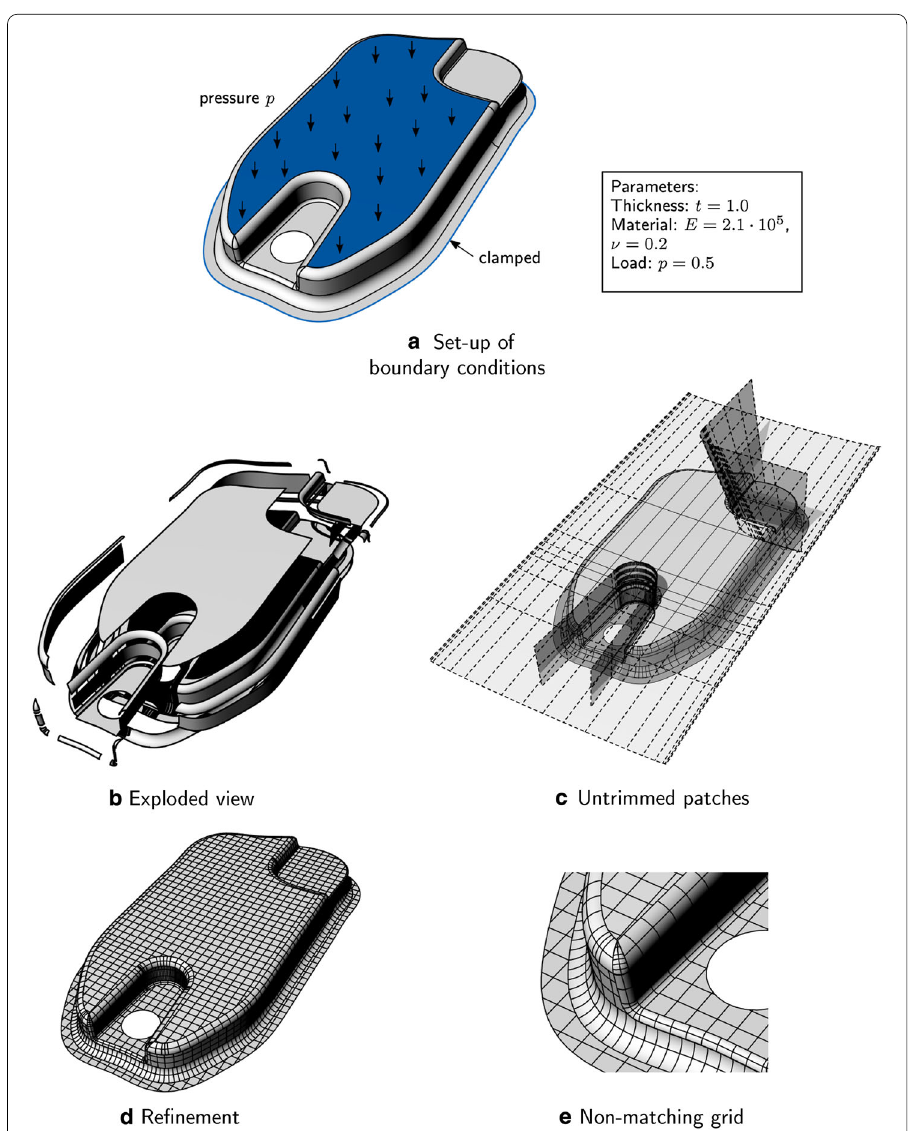
Fig. 11 Industrial example oilsump: The structure is loaded with a pressure load and the edge at the bottom is clamped, i.e. displacements and rotations ( a ). The model consists of 50 trimmed patches and 120 edges ( b , c ) [1]. The CAD model is refined for analysis such that the knot span size in the geometry space is approximately 10mm ( d ). Non-matching grid in the model is allowed ( e